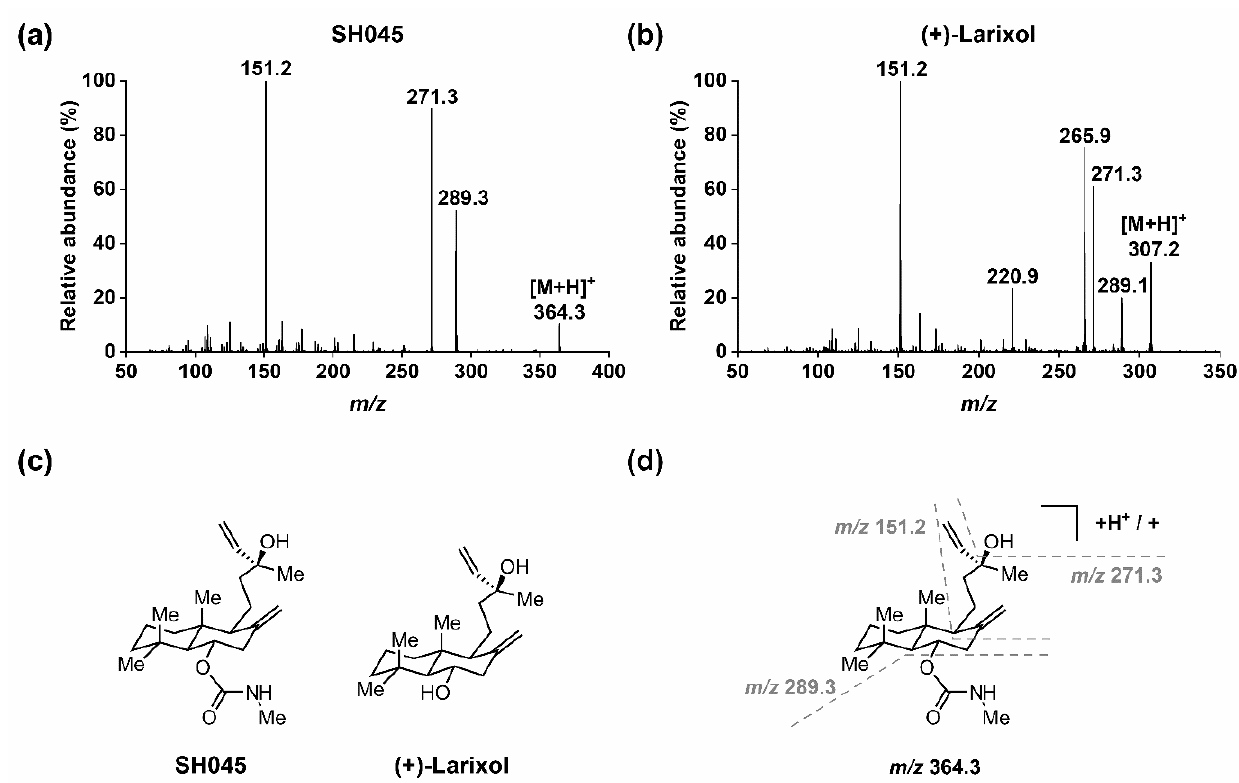
Figure 1. MS/MS of SH045 and (+)-larixol: ( a ) EPI spectrum of SH045 (product of m / z 364.3), ( b ) EPI spectrum of (+)-larixol (product of m / z 307.2), ( c ) chemical structures of SH045 and (+)-larixol and ( d ) explanation for fragmentation pattern in EPI spectrum of SH045.